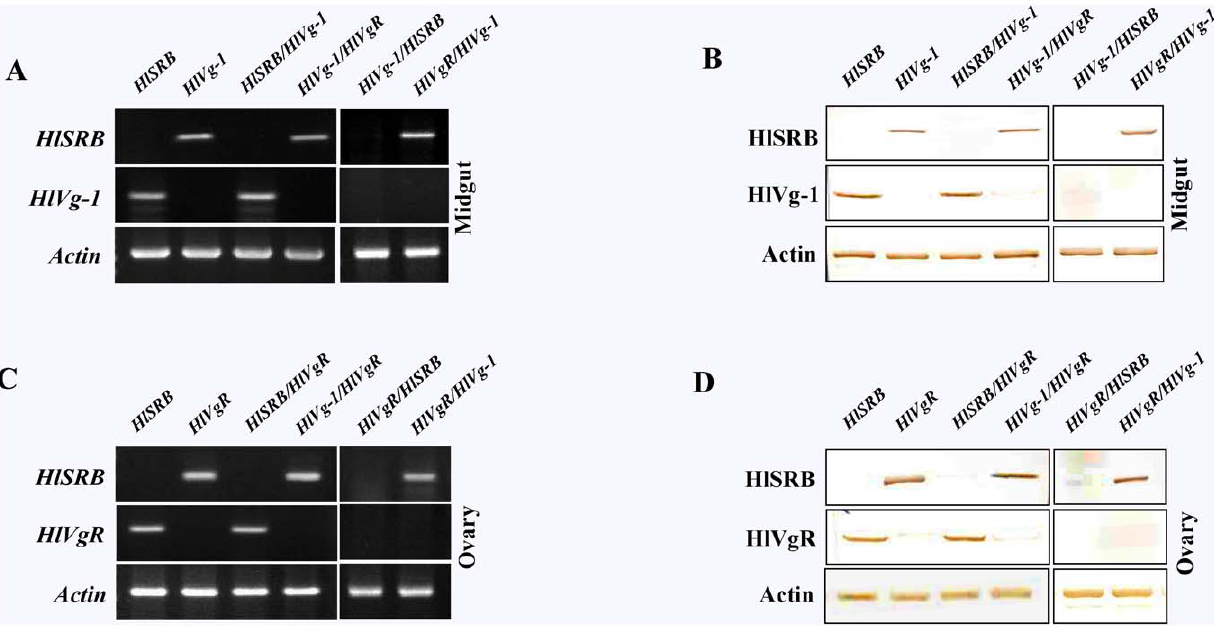
Figure 3. Expression profiles of HlSRB, HlVg-1, and HlVgR genes and proteins in different tissues of H.longicornis . Individually or in combination of HlSRB , HlVg-1 , HlVgR , and luc dsRNA(s) were injected into H. longicornis adult ticks. The midguts and ovaries of dsRNA-injected ticks at 4 days of feeding were dissected out in 0.1% diethylpyrocarbonate-treated 1 6 PBS (-) under a microscope. The name of each dsRNA group is indicated above. RT-PCR analysis and Western blot analysis were conducted using the midguts (A and B) and ovaries (C and D).